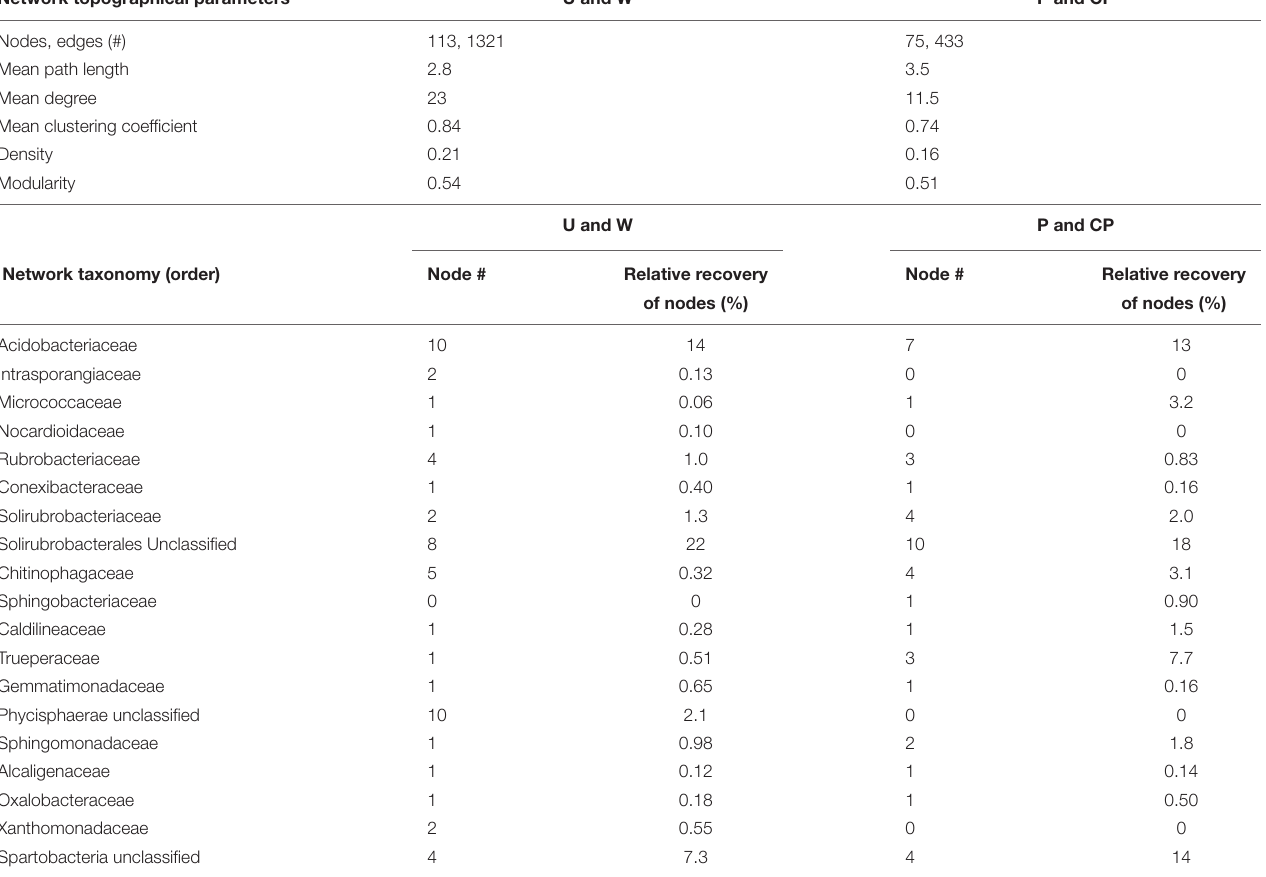
TABLE 3 | Community network model characteristics for soil bacteria in P-amended and control soils. Network topographical parameters U and